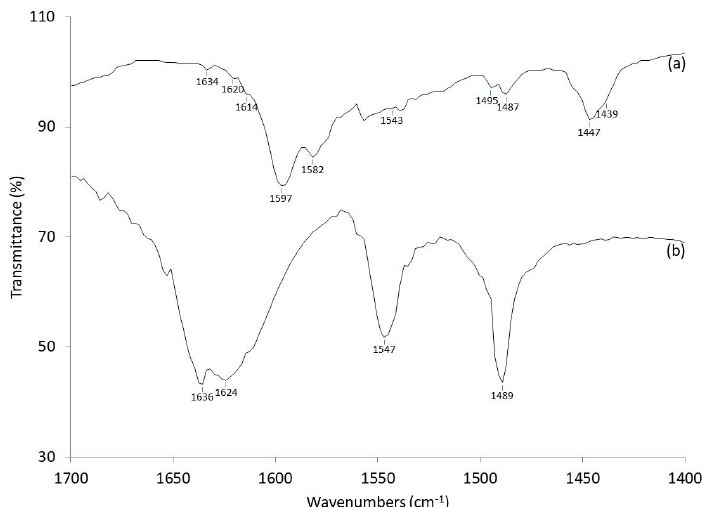
Figure 6. Subtract IR spectra of pyridine adsorbed on ZSM-5_280 (a) after evacuation of ZSM-5_280 at 350 ◦ C and pyridine adsorption at 200 ◦ C, followed by evacuation at 200 ◦ C, and (b) after exposure of ZSM-5_280 to water vapor at 280 ◦ C and pyridine adsorption at 200 ◦ C, followed by evacuation at 200 °C.